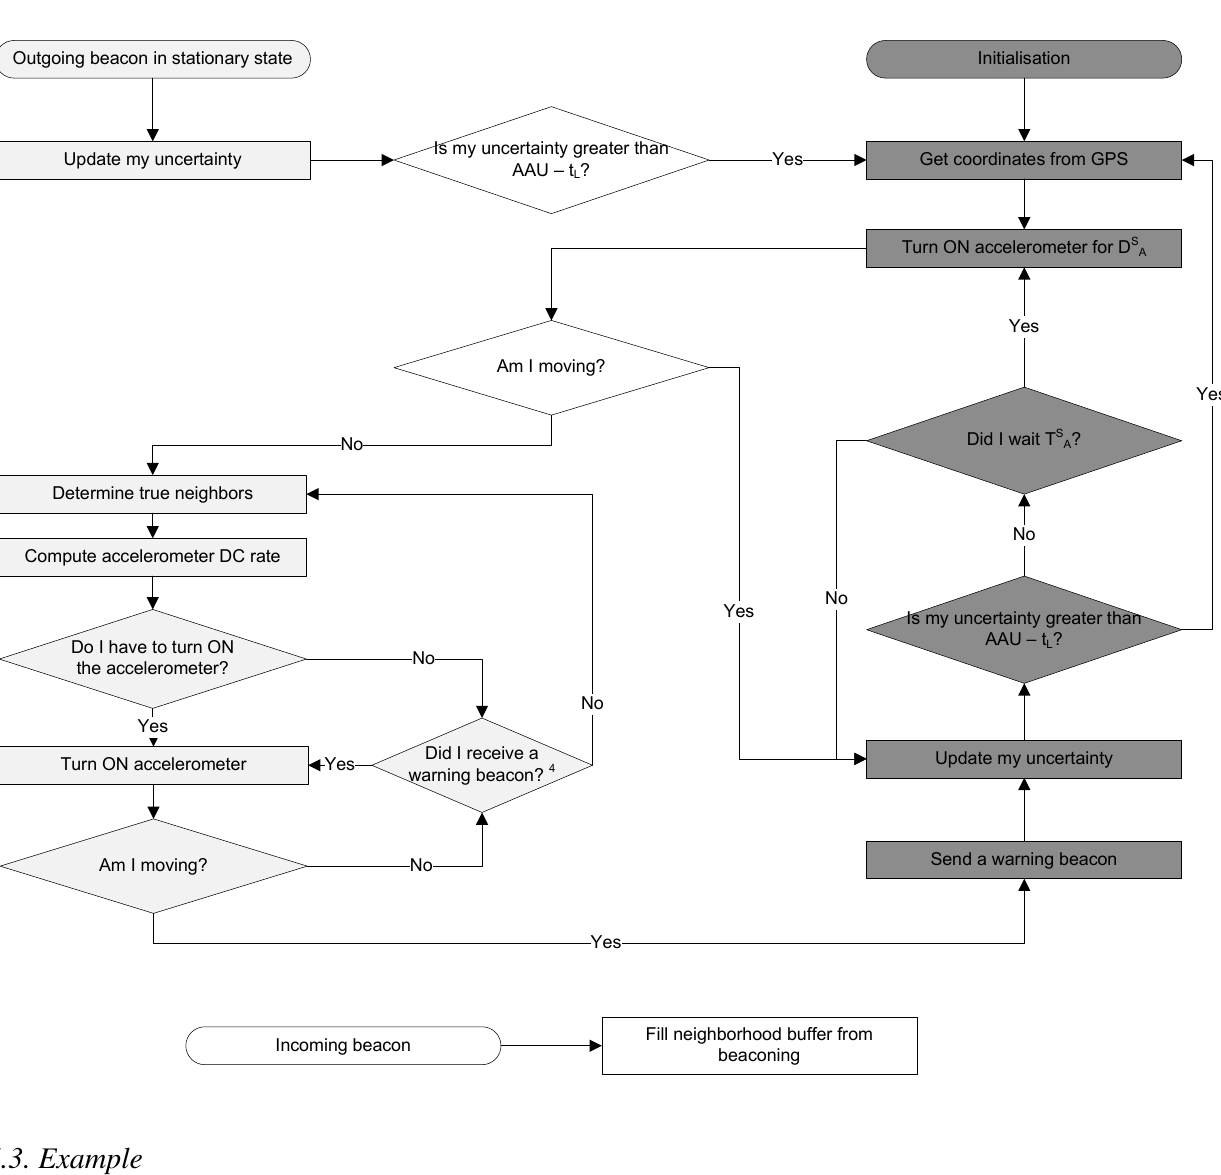
Figure 16. A flowchart of the group-based duty cycling strategy. The white and dark shaded blocks refer to the stationary and motion states